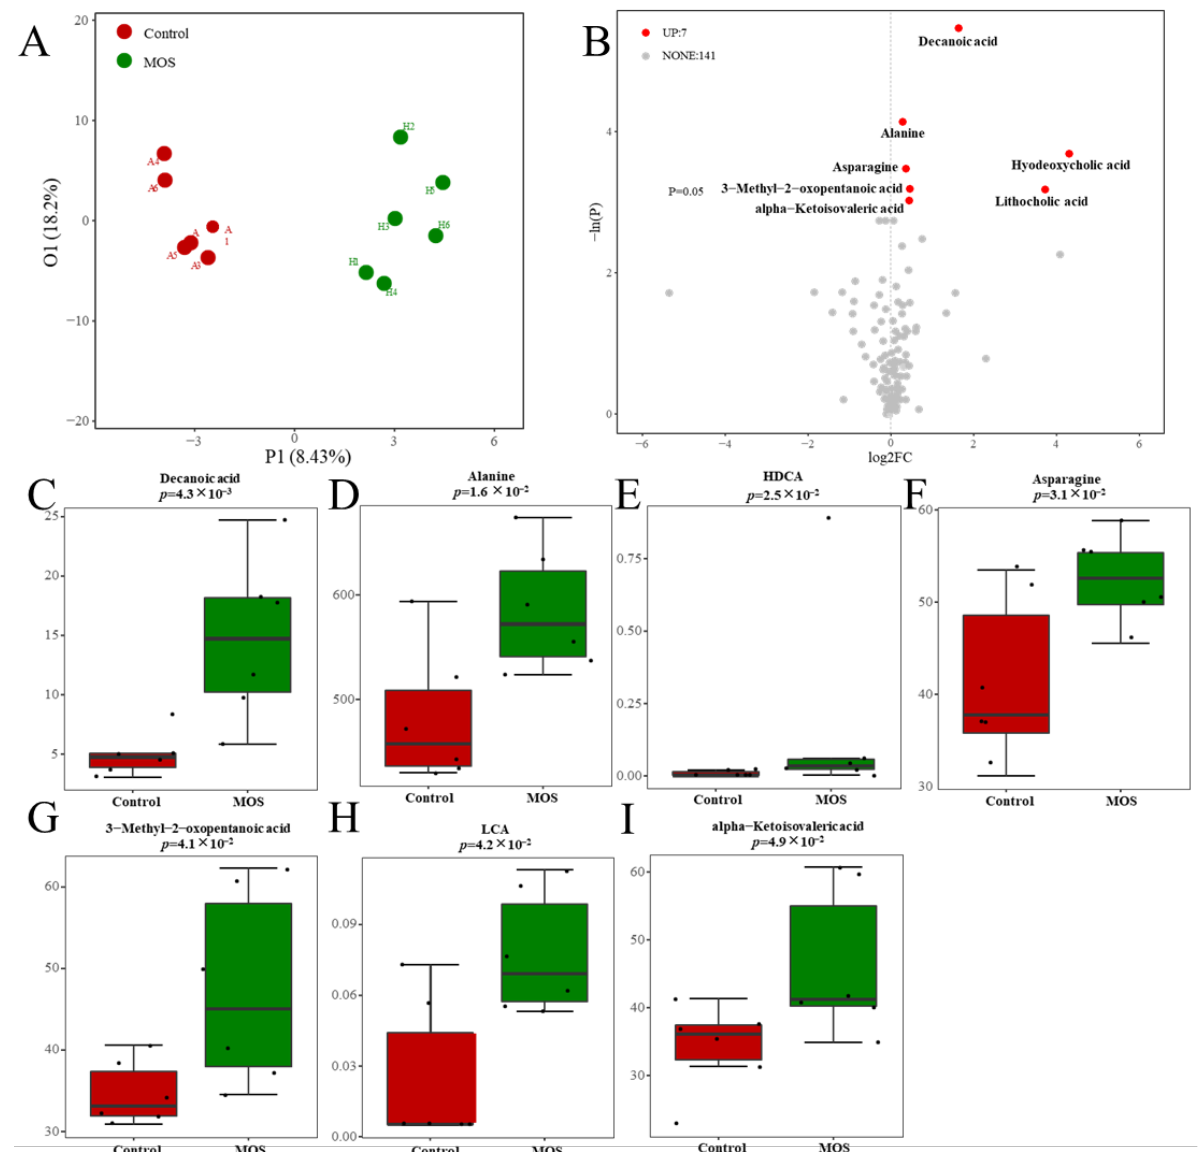
Figure 2. Serum metabolic profiles of mice fed mannan oligosaccharides. ( A ) The serum metabolome by OPLS – DA. ( B ) Metabolites in mice serum of volcano plot. ( C – I ) The box charts show the detailed serum metabolites and significant changes between the control and MOS groups (μM). Up, upregulated; FC, fold change.